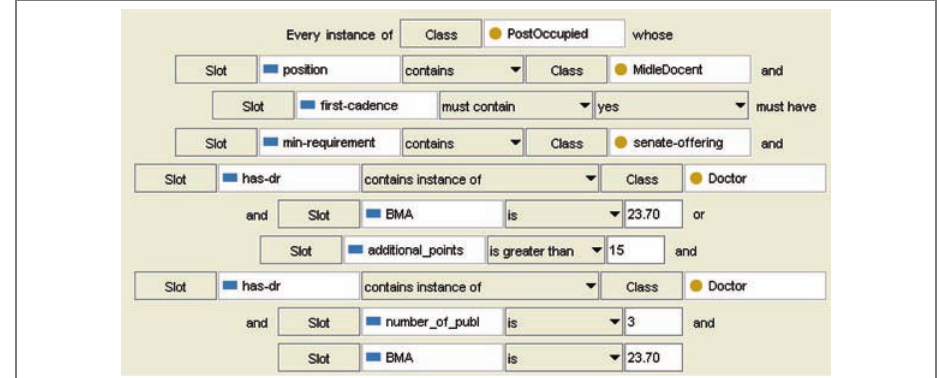
Fig. 6 . The sixth axiom defined using EZPAL Tab